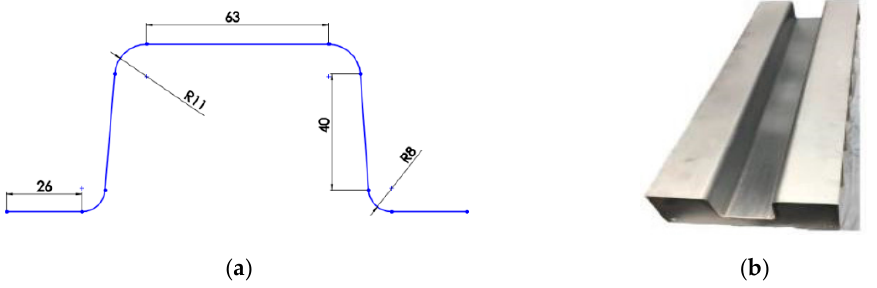
Figure 2. ( a ) Tool geometry as a mold for preparing composite samples ( b ) fabricated mold.